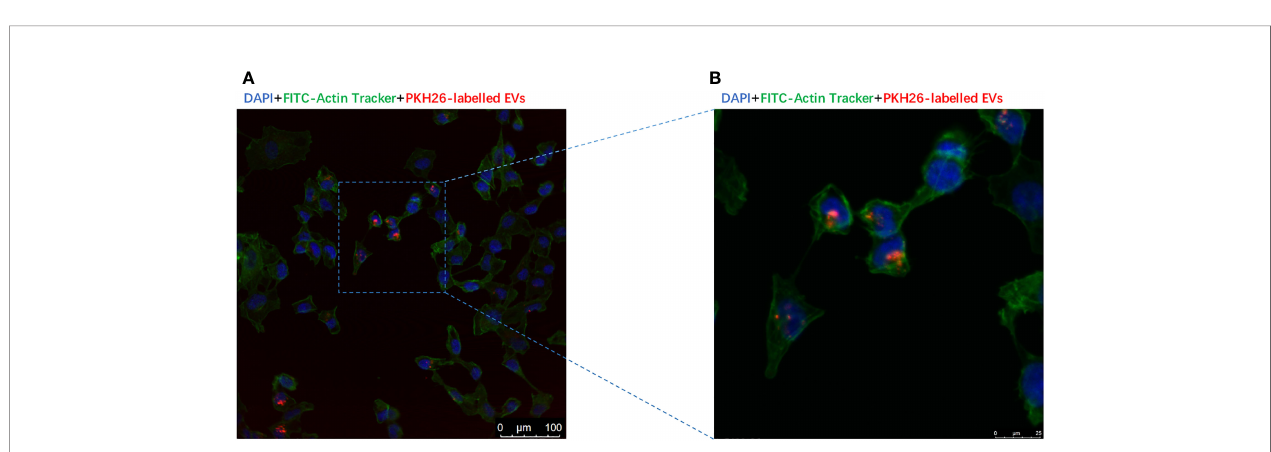
FIGURE 4 | Extracellular vesicles derived from adipocytes were internalize by CC cells. (A) The presence of extracellular vesicles derived from adipocytes in CC cells was detected by confocal microscopy after incubating the PKH26-labeled EVs derived from adipocytes (red) with CCs. The nuclei of the CC cells were stained with DAPI (blue), and their cytoskeleton of the CC cells were stained with Actin-Tracker Green (green). (B) The magni fi cation of extracellular vesicles derived from adipocytes internalized by CC